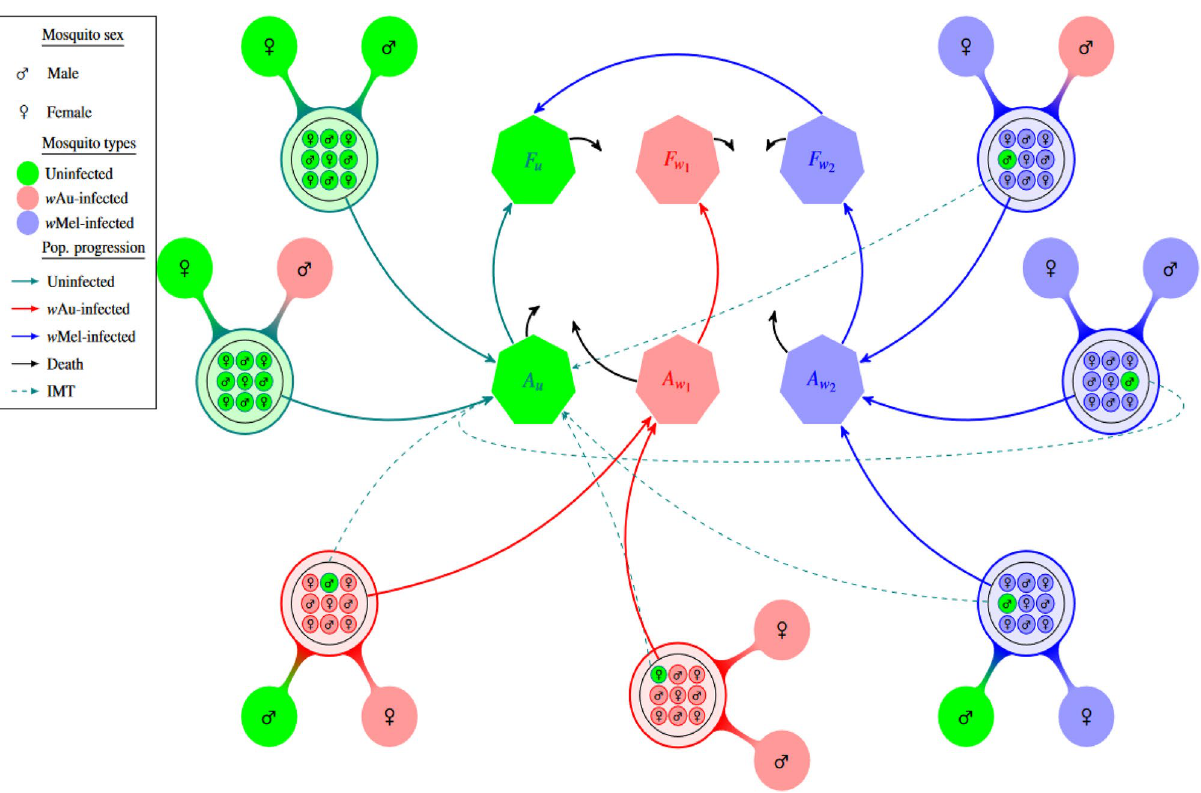
Figure 1. Model schematic of Mosquito- Wolbachia dynamics between uninfected mosquitoes u and Wolbachia -infected mosquitoes with strains w 1 ( w Au-like) and w 2 ( w Mel-like). The green, red, and blue represent the uninfected, w Au- Wolbachia -infected and w Mel- Wolbachia infected mosquito populations respectively. The lines (solid and dashed) represent the population progression where the dashed lines indicate the imperfect maternal transmission (IMT). The black arrows represent deaths. The cytoplasmic incompatibility (CI) induction which inhibits the production of offspring has been adjusted where required. A −→ Aquatic (eggs, larvae and pupae) mosquitoes and F −→ Adult